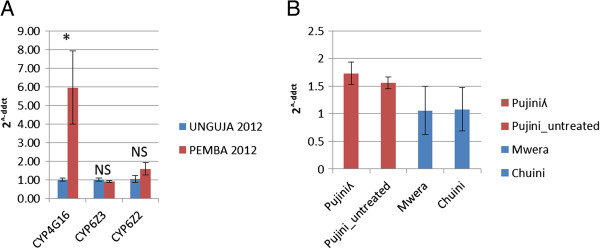
Quantitative PCR validation of candidate P450s in An. arabiensis from Zanzibar. A) Quantitative PCR (qPCR) analysis of CYP4G16, CYP6Z2 and CYP6Z3 was performed on An. arabiensis collected from Pemba (Mangwena) and Unguja (Chuini & Mwera) in 2012. The mean ± SEM for three ddCq values relative to Unguja are presented. (B)CYP4G16 expression in An. arabiensis collected in 2013. Four groups of mosquitoes were included in the analysis: (i) Pujini exposed to lambda-cyhalothrin (0.05%) (Pujiniλ) (ii) Pujini unexposed to insecticide (Pujini_untreated) (iii) Mwera (iv) Chuini. The mean ddCq values ± SEM of five biological replicates are presented. NS = non-significant. *p <0.05 one-sided Student’s t-test.